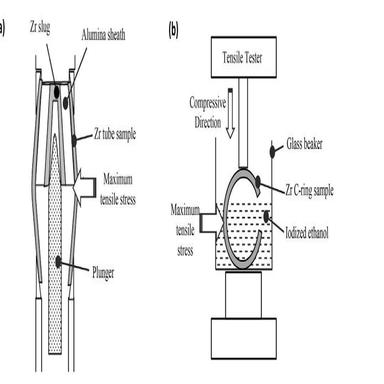
Schematics of experimental setups for (a) mandrel testing of tube samples and (b) compression testing of C-ring samples.